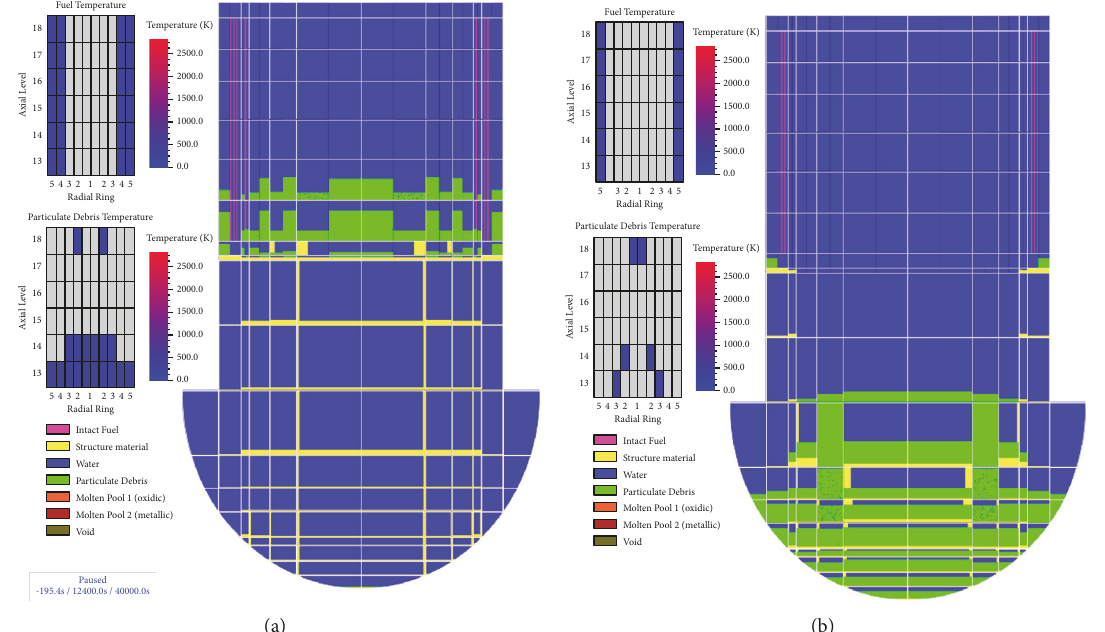
Figure 14: Core damage state for scenario with ADS time = 5500 sec and ECCS time = 9500sec at 12400sec with (a) MELCOR 2.2 and (b) MELCOR 2.1.